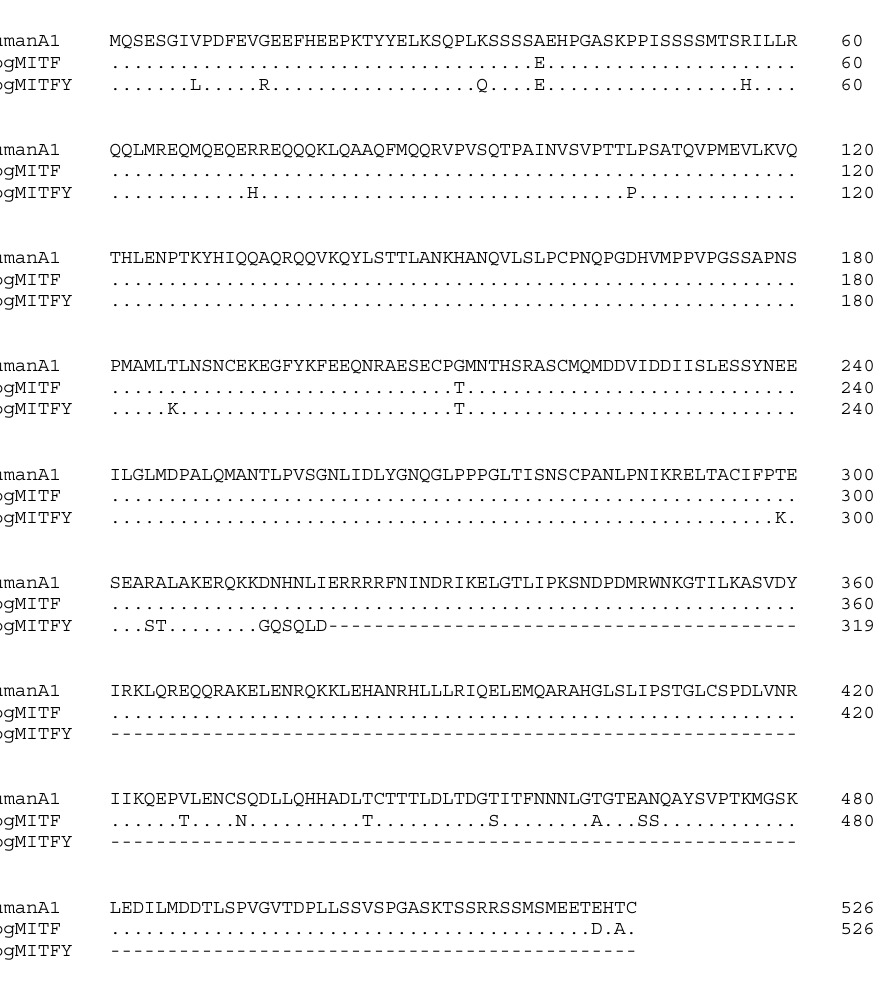
Figure 4. Alignment of MITF protein sequences: Human isoform A1, canine autosomal (CFA20), and predicted Y retrogene sequences.